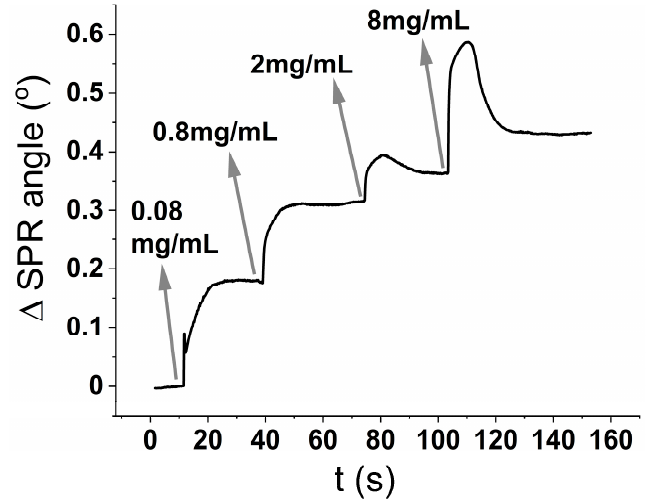
Figure 1. Surface plasmon resonance (SPR) sensogram of a kinetic titration of BSA on a macroscopic silica-coated sensor (the thickness of the silica layer was 10 nm).